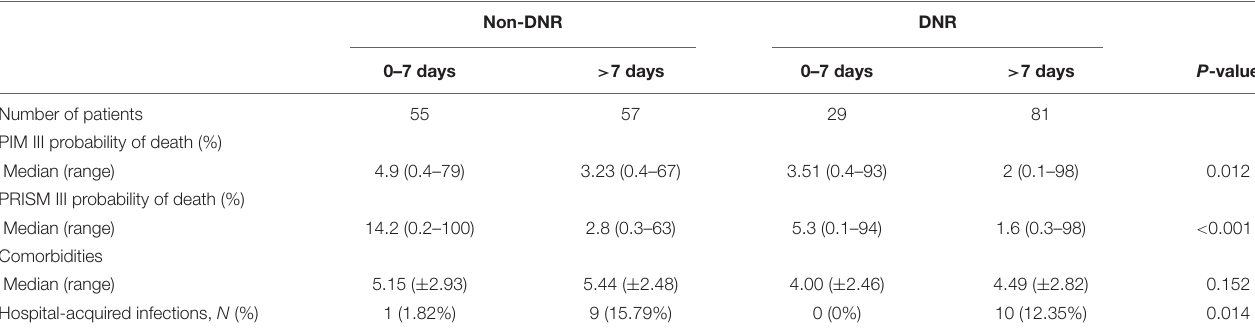
TABLE 7 | Characteristics of the non-survivors according to do-not-resuscitate